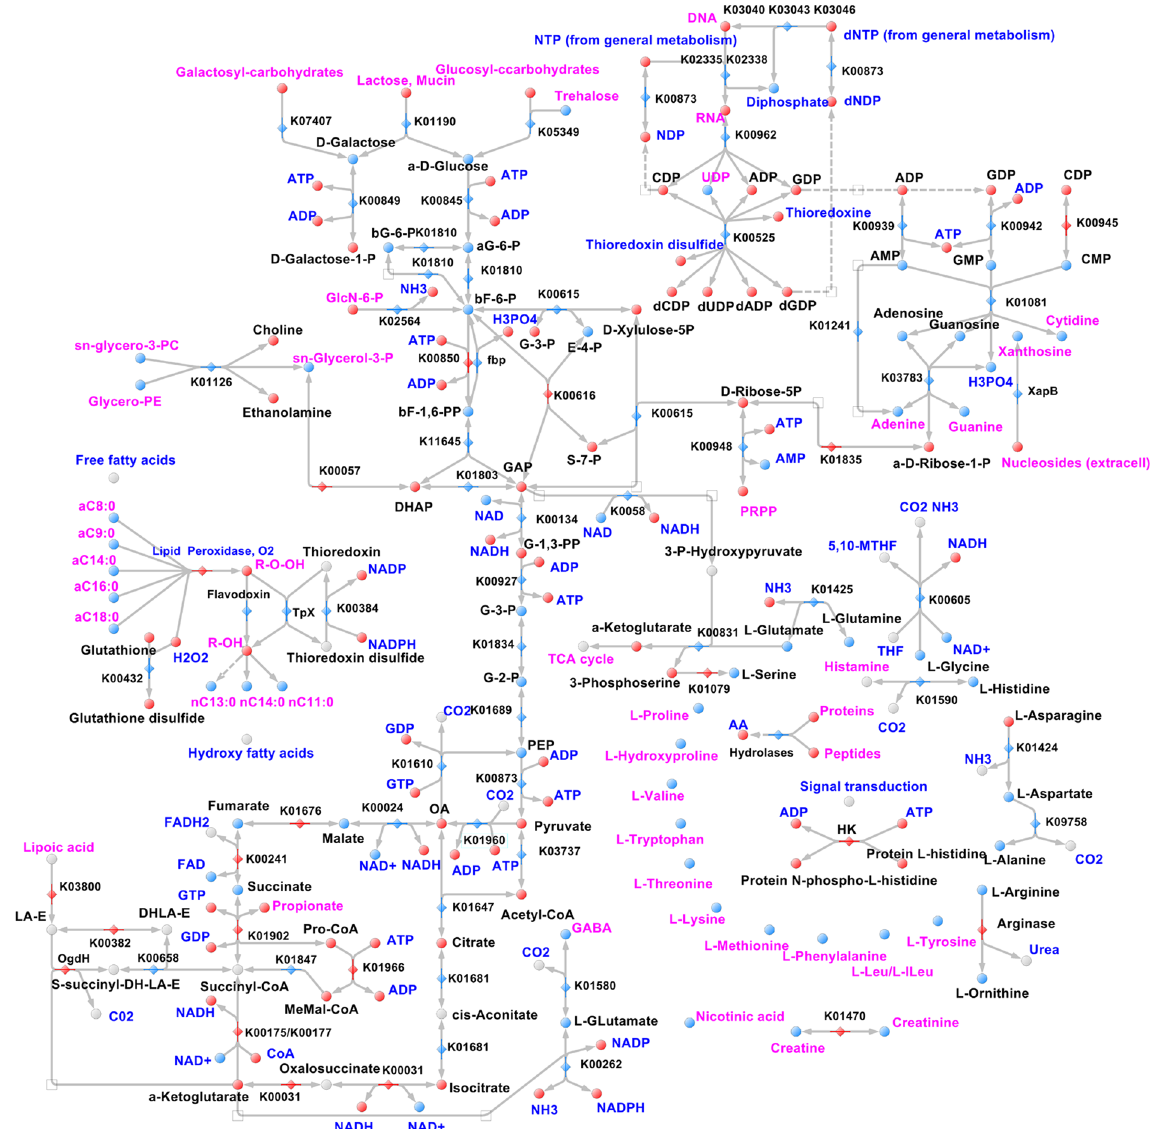
Figure 7. Reconstructed metabolic maps of ETBF OMVs. Metabolites that are identified/not identified are colored in blue/red spheres. The blue/red rhombus indicates identified/not identified enzymes. The main reconstructed pathways are shown in the picture. sn-glycero-3-phosphocholine- sn-glycero-3-PC; Glycerophosphoethanolamine-Glycero-3-PE; bG-6-Pb-D-Glucose-6-phosphate; aG-6-Pa-D-Glucose- 6-phosphate; bF-6b-D-Fructose-6-phosphate; E-4-PD-Erythrose-4-phosphate; GAPD-Glyceraldehyde- 3-phosphate; G-3-PD-Glycerate-3-phosphate; G-2-PD-Glycerate-2-phosphate; G-1,3-PPD-Glycerate- 1,3-bisphosphate; dF-1,6-PPb-D-Fructose-6-bisphosphate; S-7-P - D-Sedoheptulose-7-phosphate, dihydrolipoamide E - DHLA-ELipoamide-E -LA-ES-succinyl-DHLA-E - S-succinyl-dihydrolipoamide- EPropanyl-CoA - Pro-CoAMethylMalonyl - CoA - MeMal-CoAOxaloacetate - OAPhosphocholine - PCPhosphoethanolamine - PE5,10-Methylene-THF - 5,10-MTHFL-Leucine/L-Isoleucine - L-Leu/L- ILeuHistidine kinase